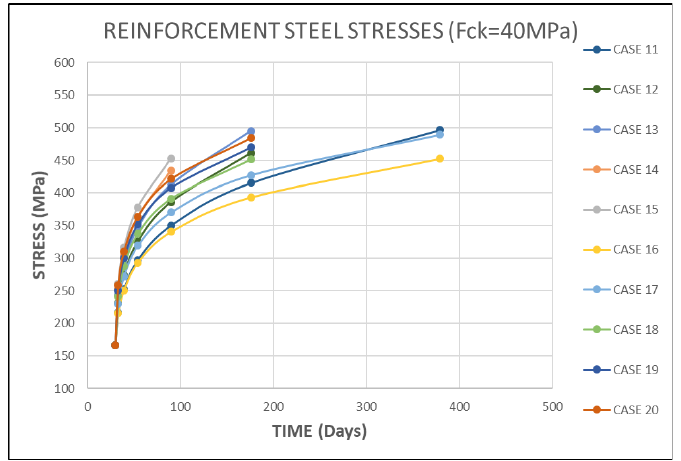
Figure 13. Stresses evolution on the reinforcement bars - C40 Concrete.